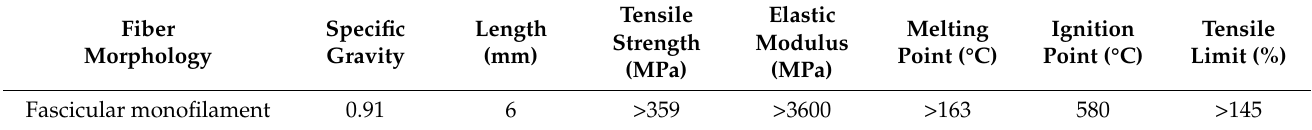
Table 2. Physical indicators of polypropylene